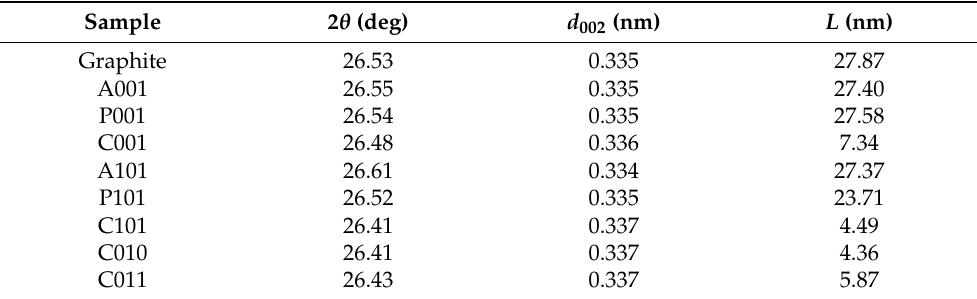
Table 3. XRD peak positions, interplanar spacing d 002 and crystallite size of the annealed and water-treated GBS